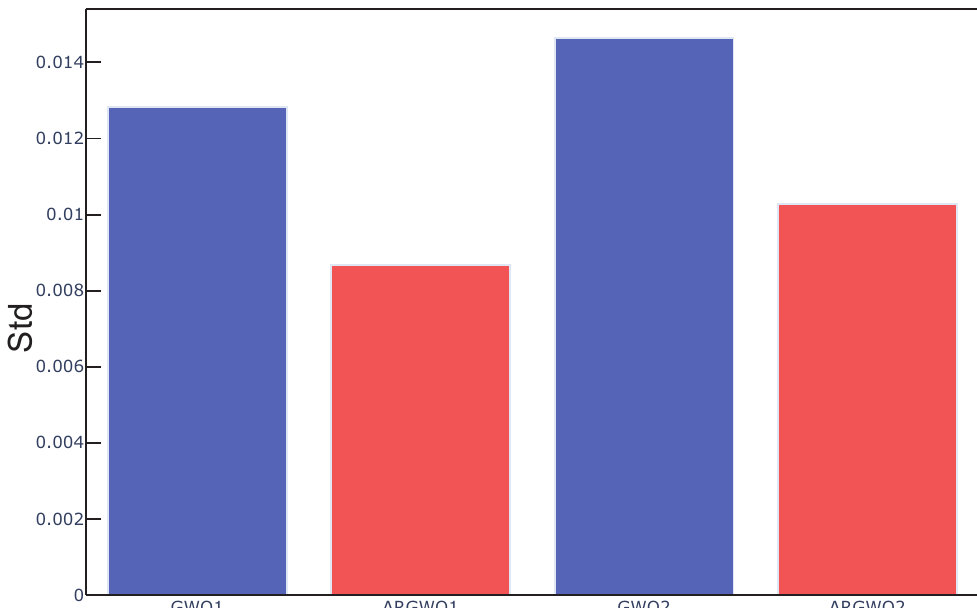
Figure 8. Std measure average over all the data sets for the different